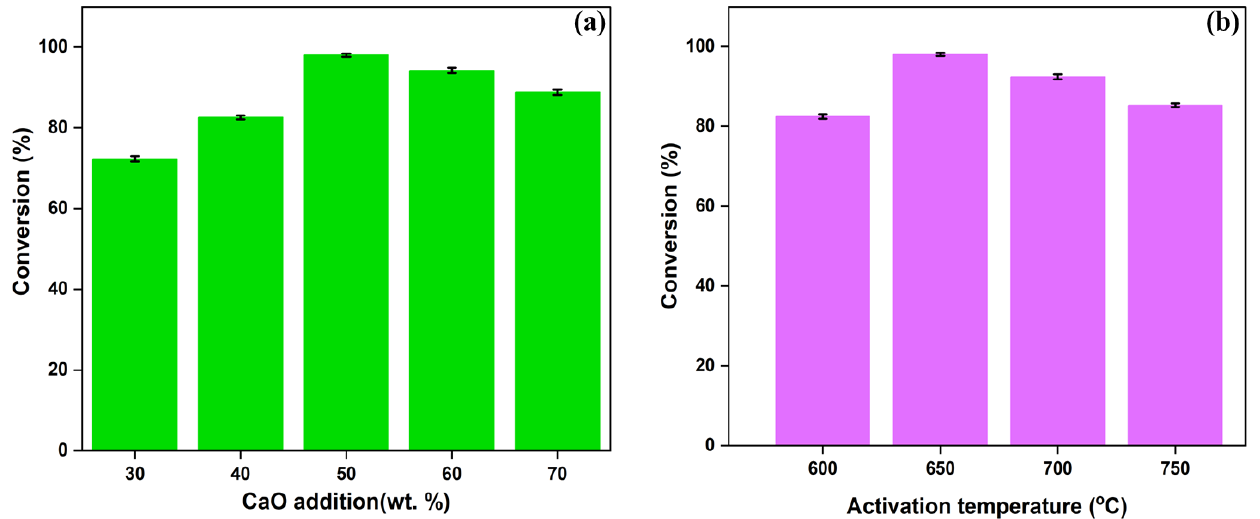
Figure 1. Effect of ( a ) CaO loading and ( b ) activation temperature on catalytic activity under opti- mised condition.